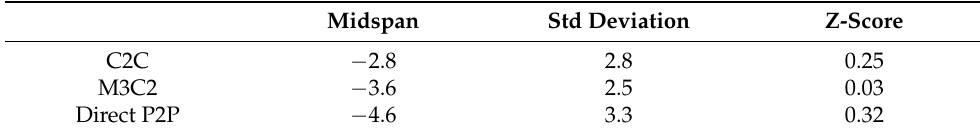
Table 12. Statistical evaluation of deformation